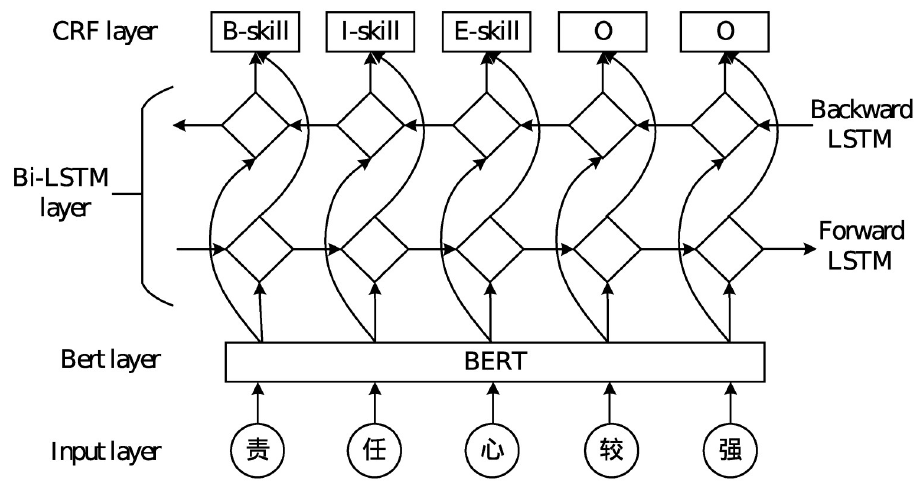
Fig 3. Framework of BERT-BiLSTM-CRF